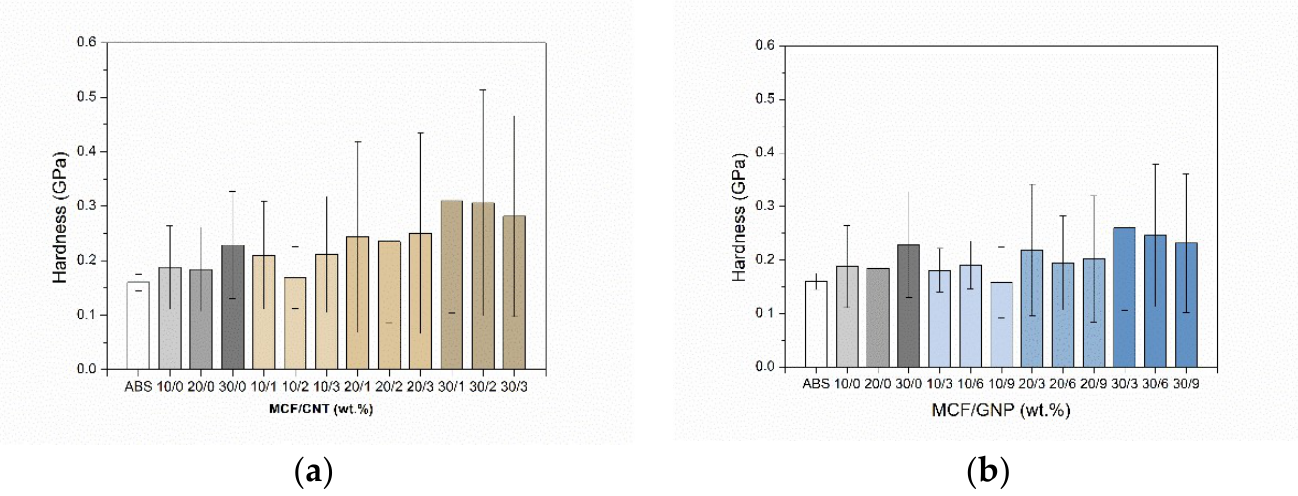
Figure 7. Hardness of CM samples as determined from nanoindentation test at different ( a ) carbon nanotube and ( b ) graphene contents in MCF/CNT and MCF/GNP composites, respectively. The relative ratio of MCF vs. CNT or GNP is reported in percentage by wt.